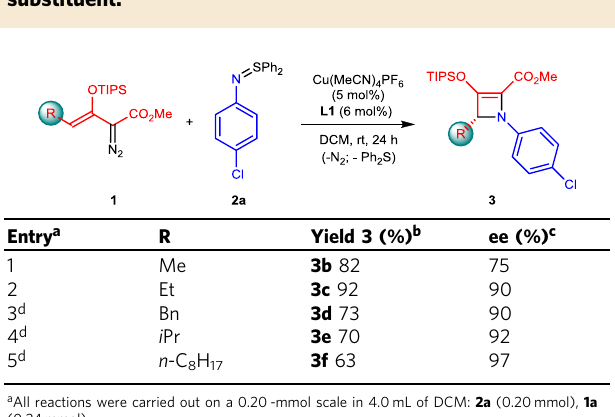
Table 1 Scope of enoldiazoacetates: effect of the R- substituent.